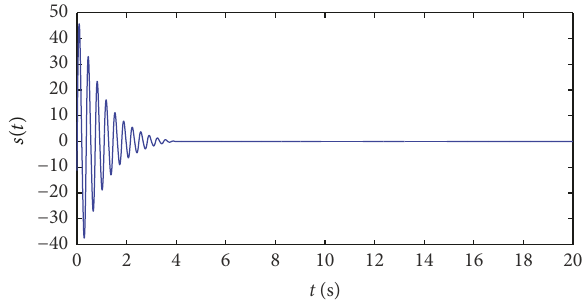
Figure 9: Sliding surface 𝑠(𝑡) response with time 𝑡 .